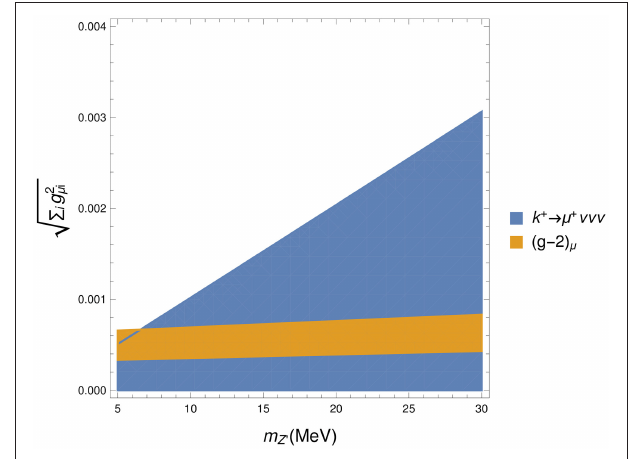
2 FIGURE 10 | 90 % C.L. constraints on i g ei vs. m Z ′ from constraints on qP e + ννν [208] branching ratios, from current and e ν Z ′ [207] and K + π −→ −→ projected R π measurement by PIENU [209] and from the R K measurement by